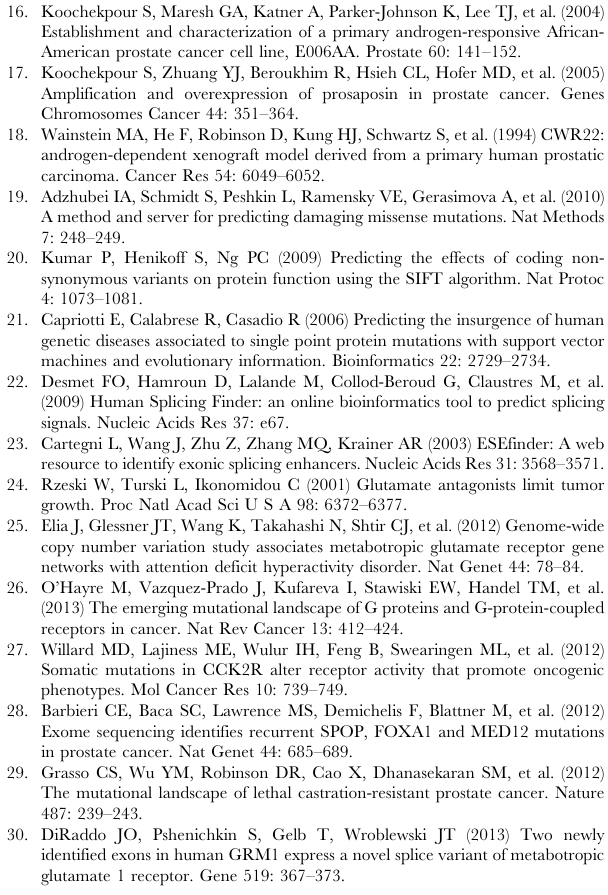
Table S1 Details of primers used for sequencing of GRM1 gene. Genomic sequences of primers used for PCR and sequencing in accordance with Human Genome Assembly